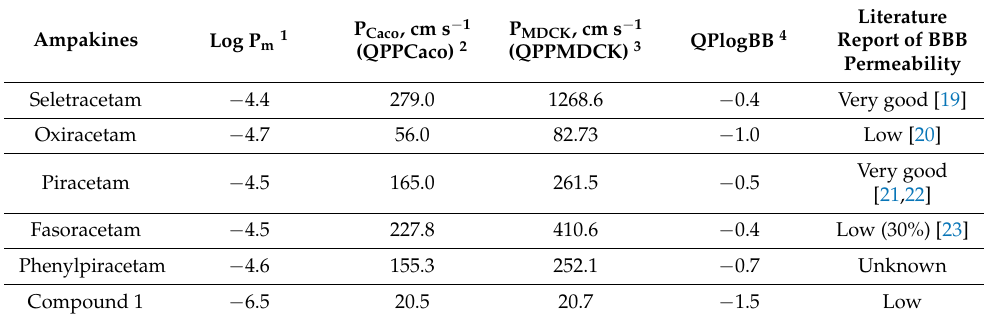
P Caco , cm s − 1 (QPPCaco) 2